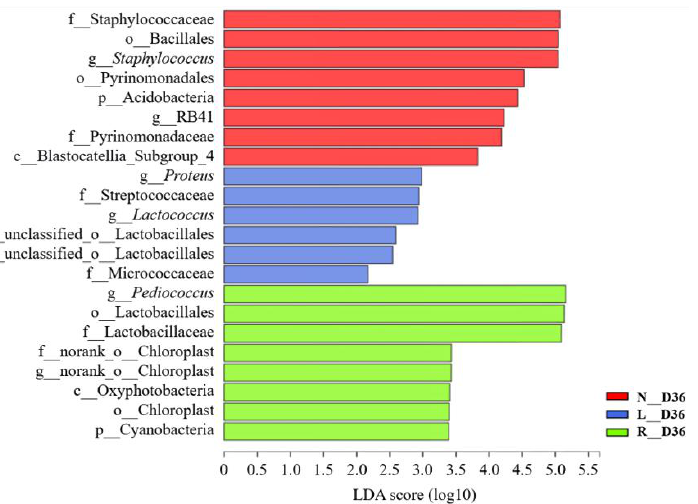
Figure 5. Horizontal bar chart of bacterial markers among the three groups (N, L and R) of sam- ples on day 36 based on linear discriminant analysis (LDA). Bacterial taxa were significantly discriminant taxa from the phylum to genus levels with LDA scores higher than 2.0. The letters o_, f_ and g_ represent bacterial order, family and genus, respectively. N: fermented sausages with 3% NaCl (reference), L: fermented sausages with 2.25% NaCl (25% reduction), R: fermented sausages with partial replacement of 25% NaCl.